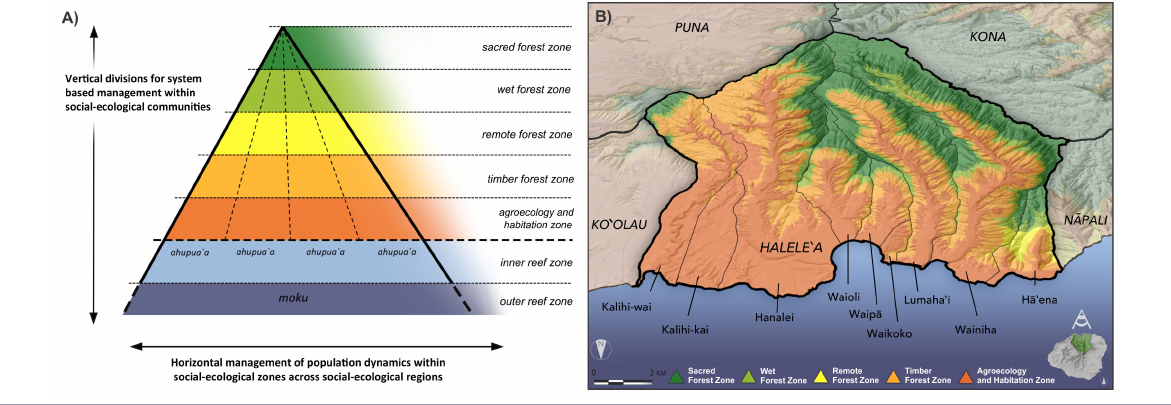
Fig. 1. A schematic model (A) and a spatial model (B) depicting the layout of a single social-ecological region ( moku ) based on the Hawaiian social-ecological system on the island of Kaua ʻ i. (A) The terrestrial and oceanic social-ecological zones and their subcategories are oriented horizontally. Ahupua ʻ a or social-ecological communities are oriented vertically. (B) The moku of Halele ʻ a encompasses numerous ahupua ʻ a, each with jurisdiction over a full spectrum of terrestrial and oceanic social-ecological zones within its boundaries. Data for this figure came from Winter et al. 2018